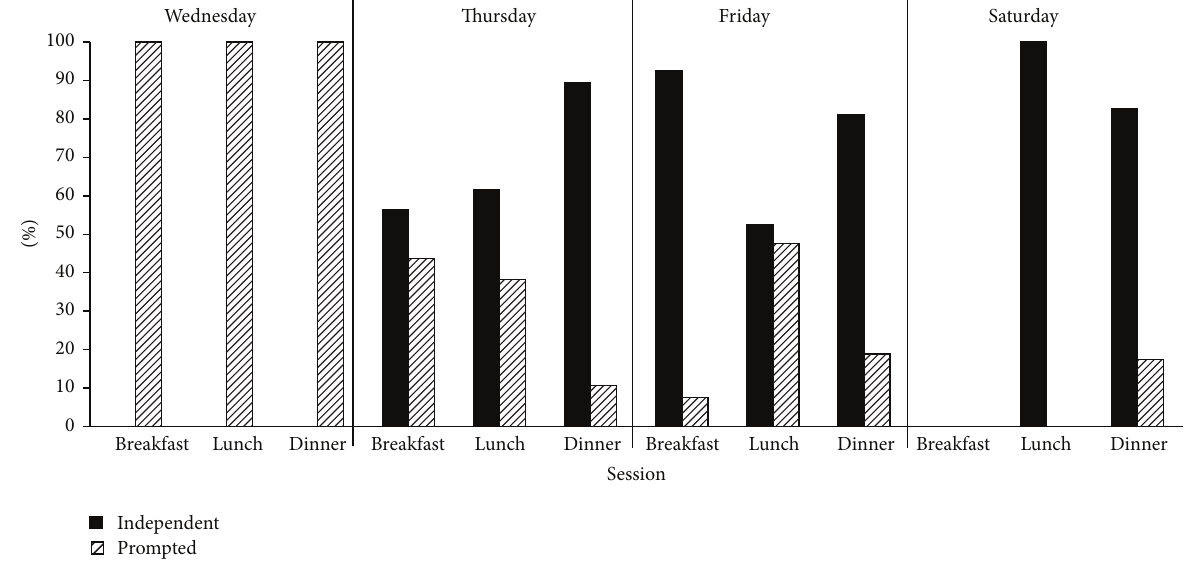
Figure 3: Percent of bites taken